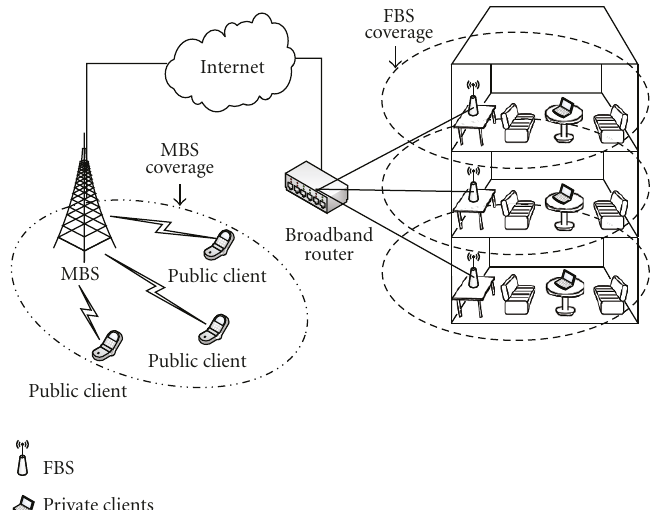
Figure 2: Femtocell Operation. The femtocell architecture consists of several private base stations called FBSs, which service private clients who own these FBSs. A main base station called MBS also exists to provide service to nonfemtocell owners, called public clients.